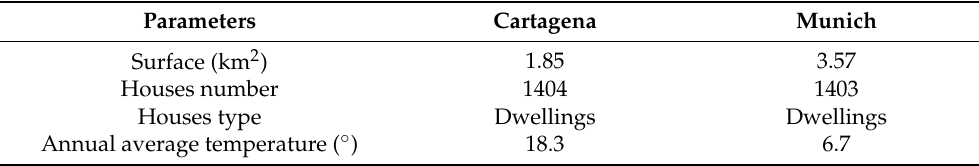
Figure 2. Location of the study areas. Campo de Cartagena’s municipality and the study area’s cadastral view are on the lower left. The city of Munich in Germany and the study area are on the right. Table 1. Study areas